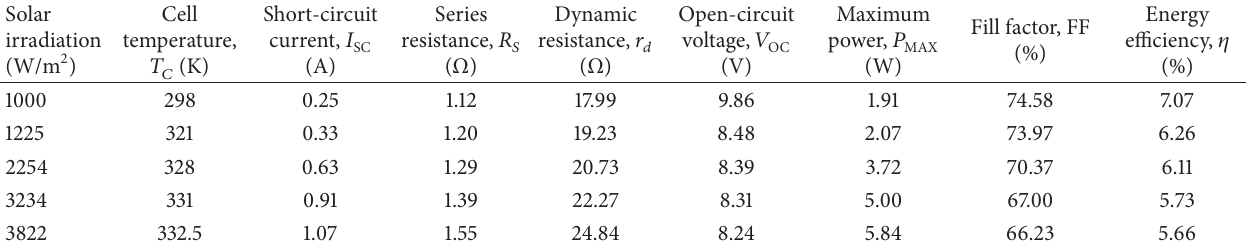
Table 5: Parameter estimated from 𝐼 - 𝑉 curves plotted under various CR.